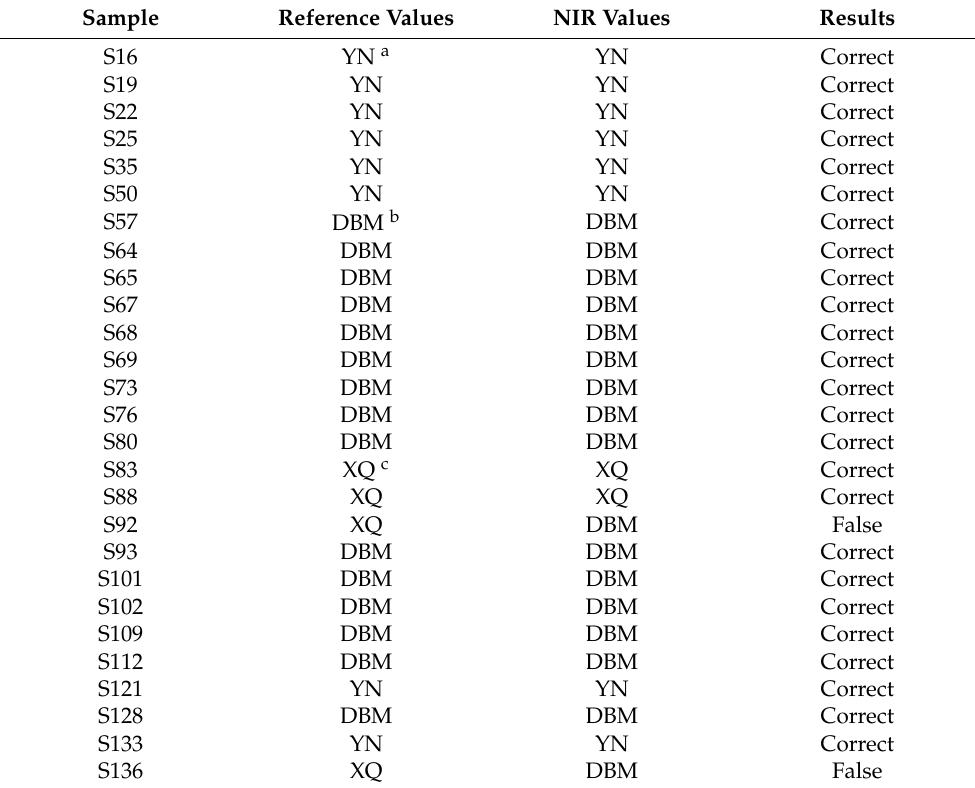
Table 3. Comparison between reference values and the values determined by NIR spectroscopy and RFM in validation samples.